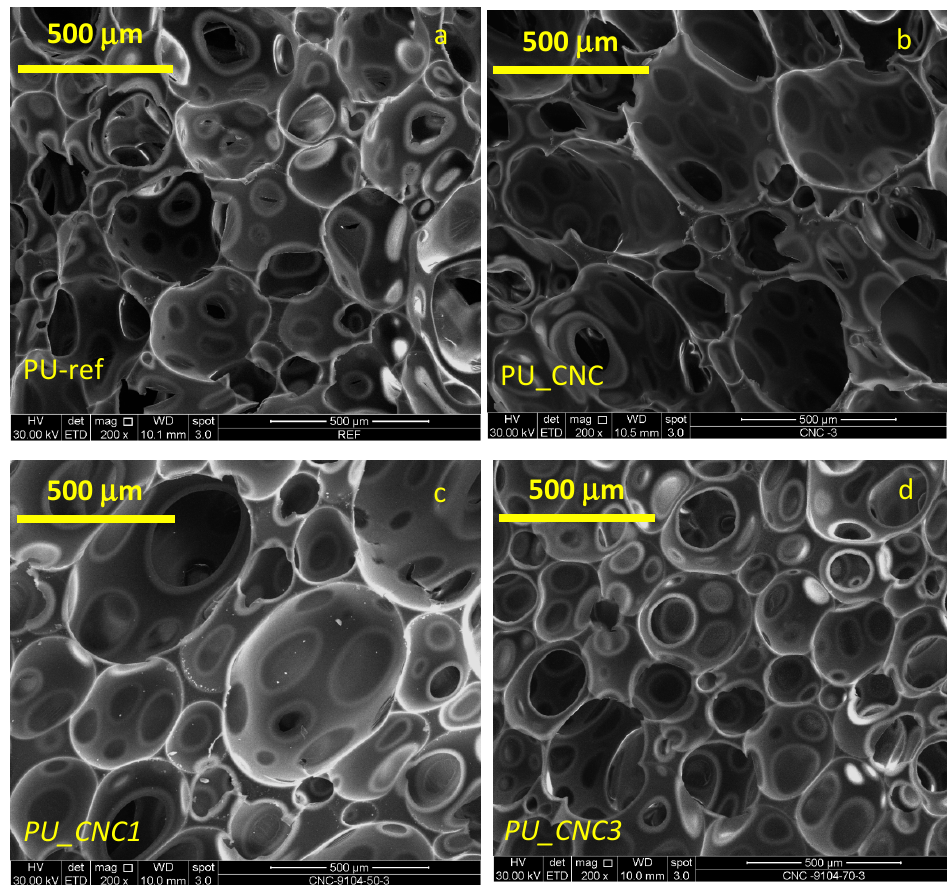
Figure 6. SEM images of PU reference (PU-ref) ( a ) and of PU with 3 wt% of pristine CNC (PU_CNC) ( b ), 3 wt% of CNC1 (PU_CNC1) ( c ) and 3 wt% of CNC3 (PU_CNC3) ( d